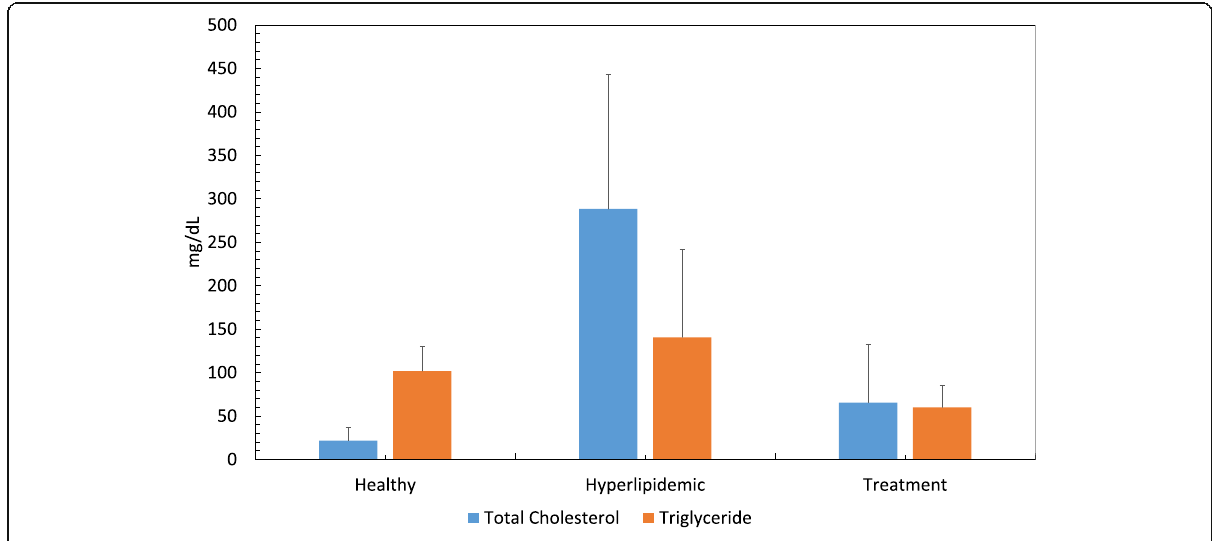
Fig. 3 Serum total cholesterol and triglyceride levels by periods